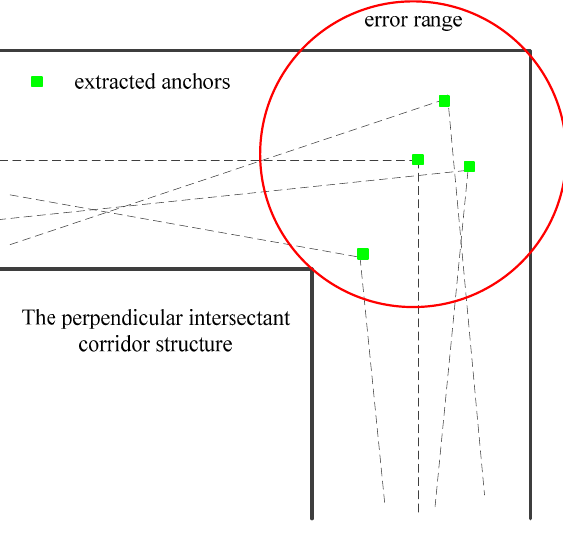
Figure 8. Noise assumption in the observation model.